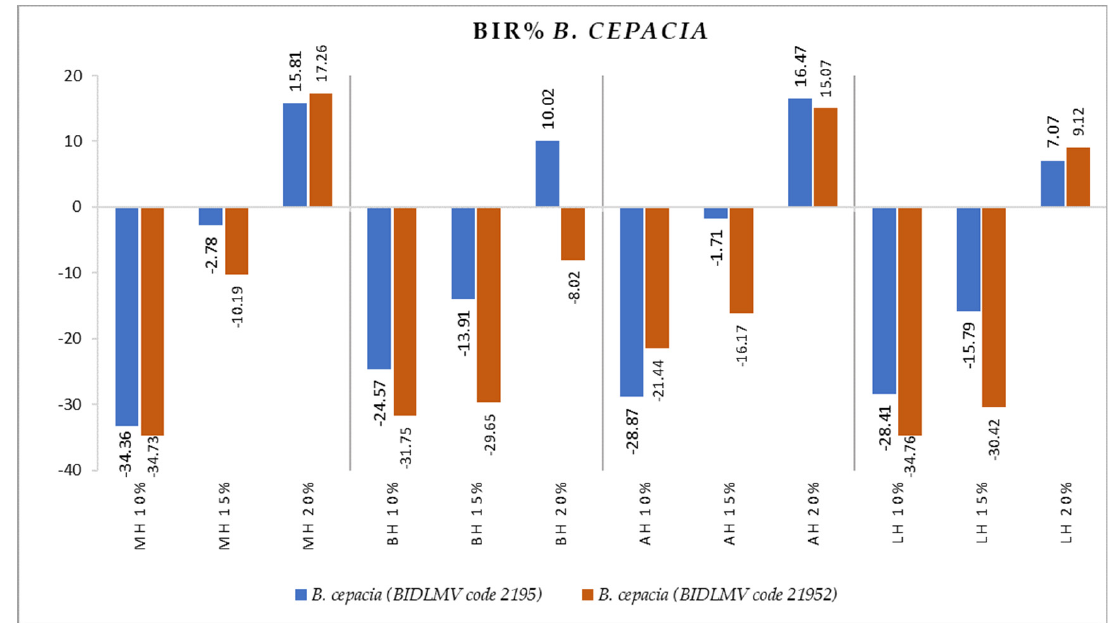
Figure 8. Antimicrobial activity (expressed as BIR%) of honey samples tested on E. coli isolates.